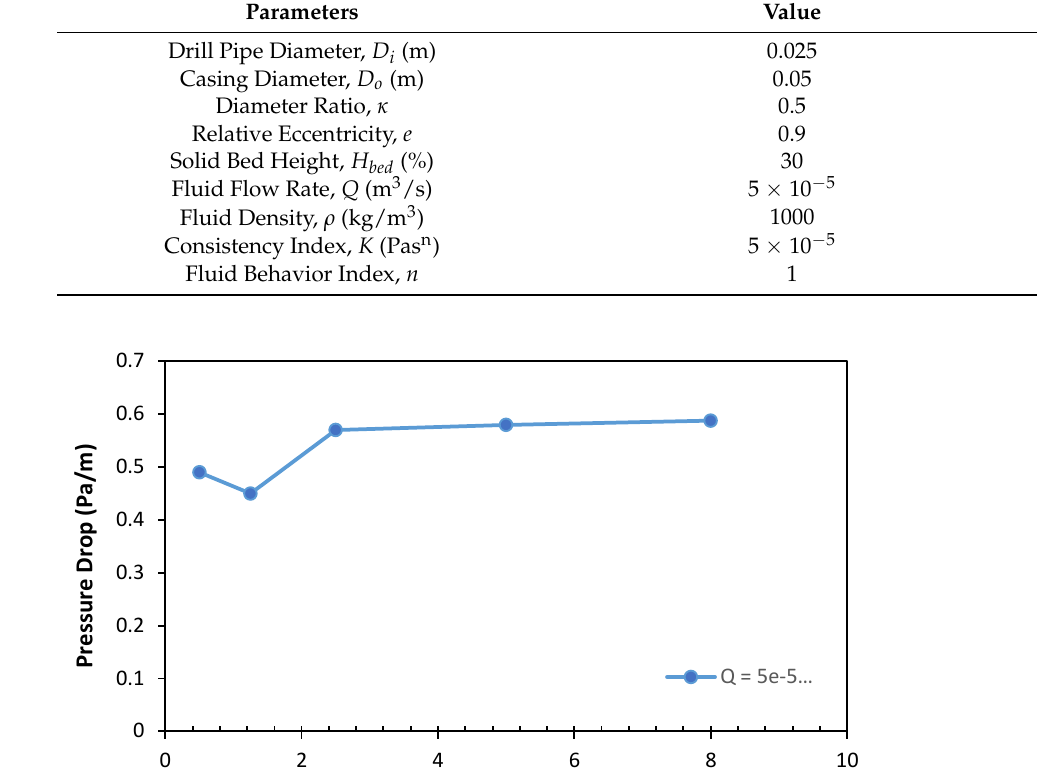
Table 1. Inputs used for simulation.